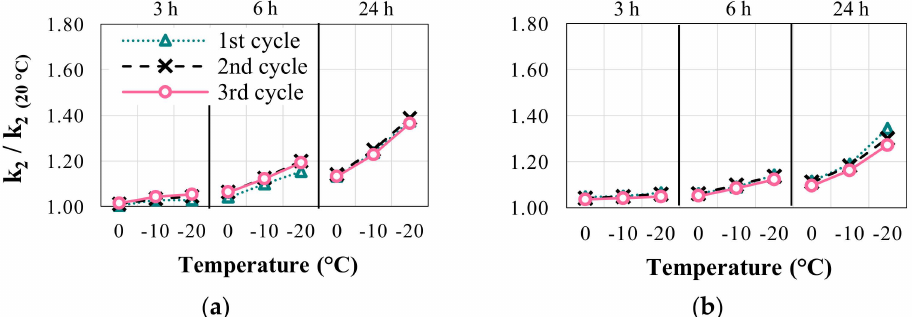
Figure 13. Comparison of normalized post-yield stiffness for 0.1 Hz loading frequency at ( a ) 100% and ( b ) 134% shear strains.